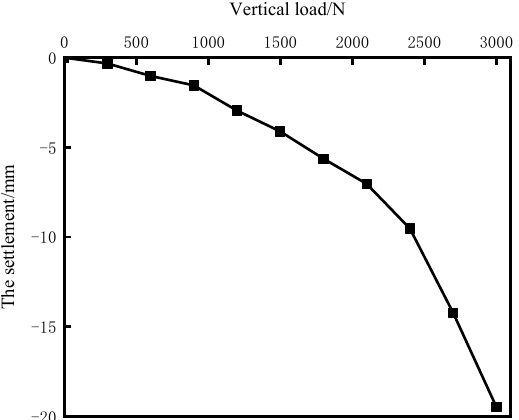
Figure 5. The settlement curve of the CFMP fly ash composite foundation under static load.